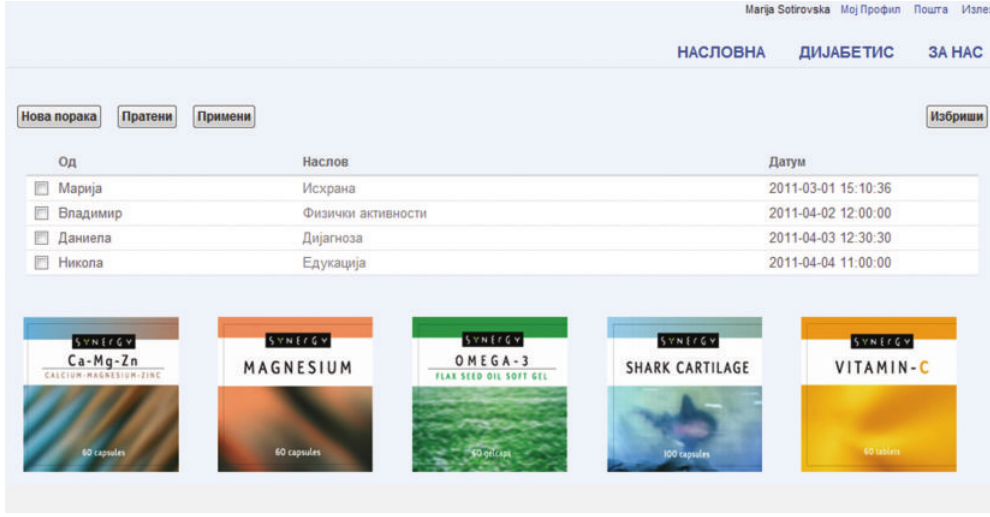
Figure 3: Professional health care support service.